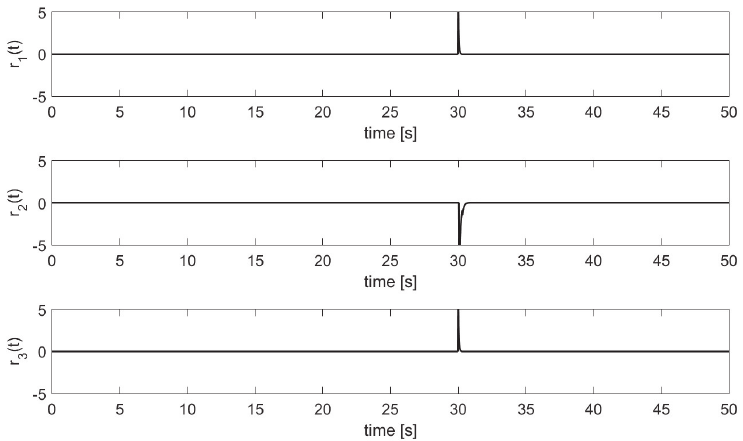
Figure 3. Response of residual to the sensor fault f s 1